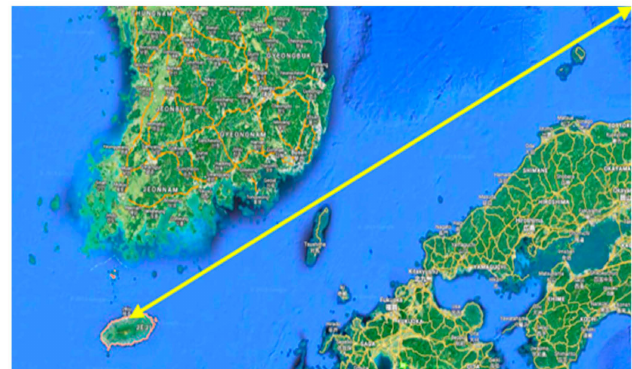
Figure 9. The arrow points representing the distance between the control tower and the corner of the